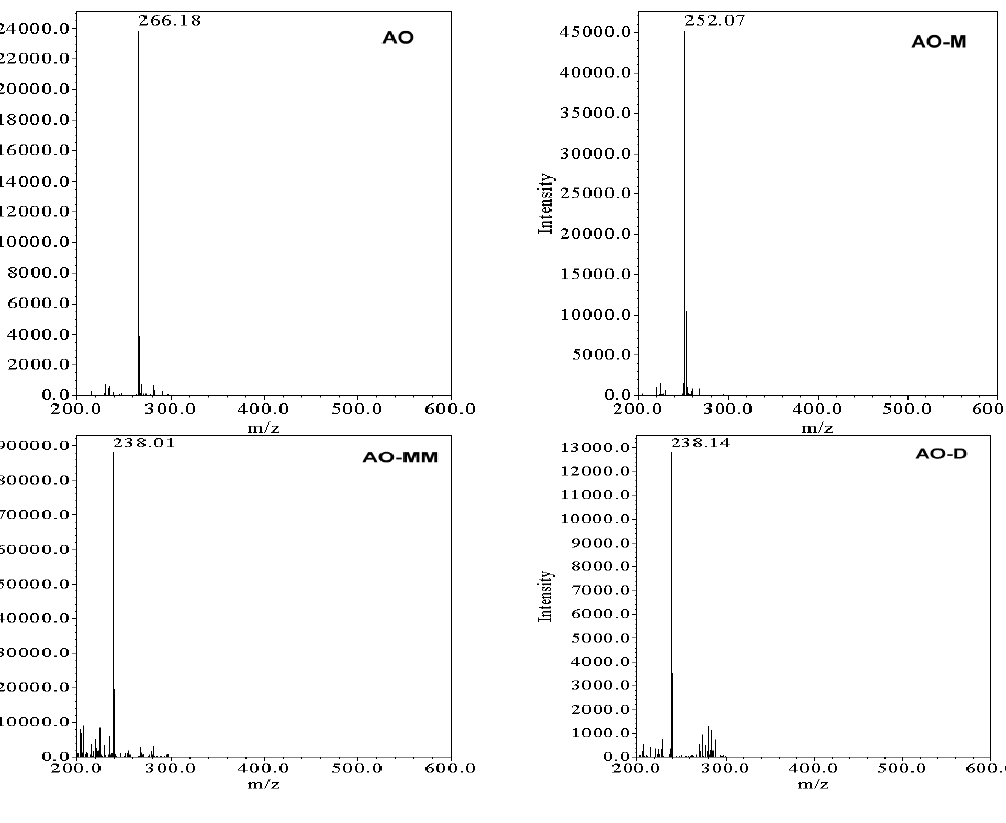
Figure 11. ESI mass spectra of the N -de-methylated intermediates formed during